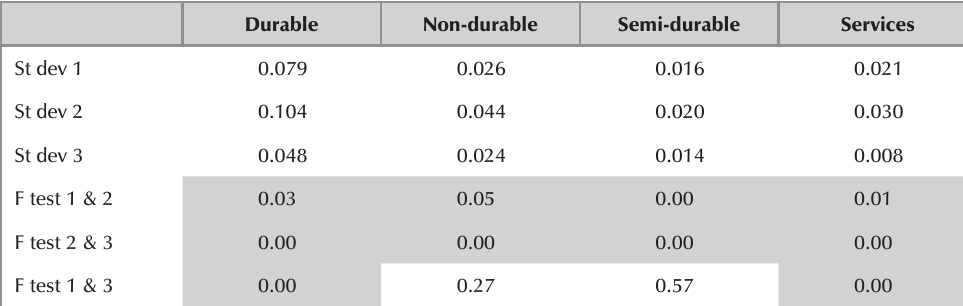
Standard deviations of the components of